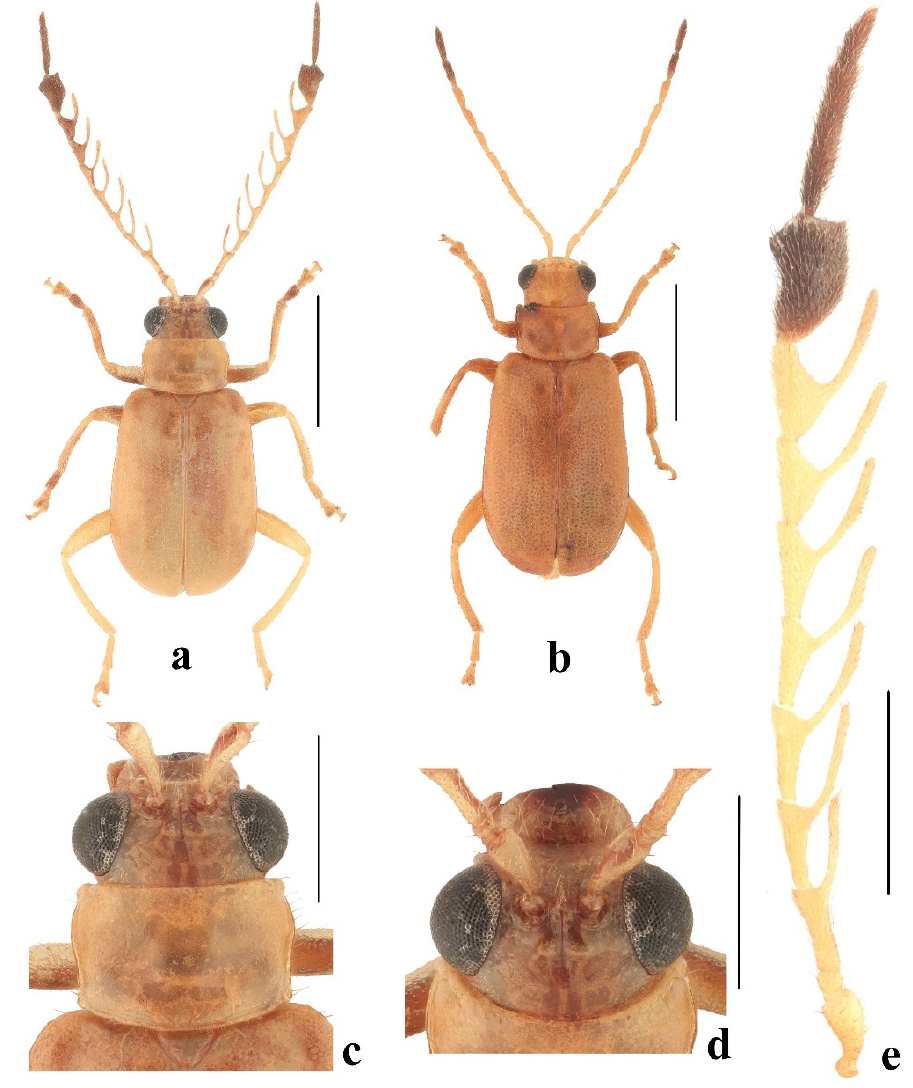
Figure 5. Taumacera lewisi (Jacoby, 1887): ( a ) male; ( b ) female; ( c ) head and pronotum, dorsal view; ( d ) head, frontal view; ( e ) left antenna. (Scale bars: ( a , b ) = 2 mm, ( c – e ) = 1 mm).